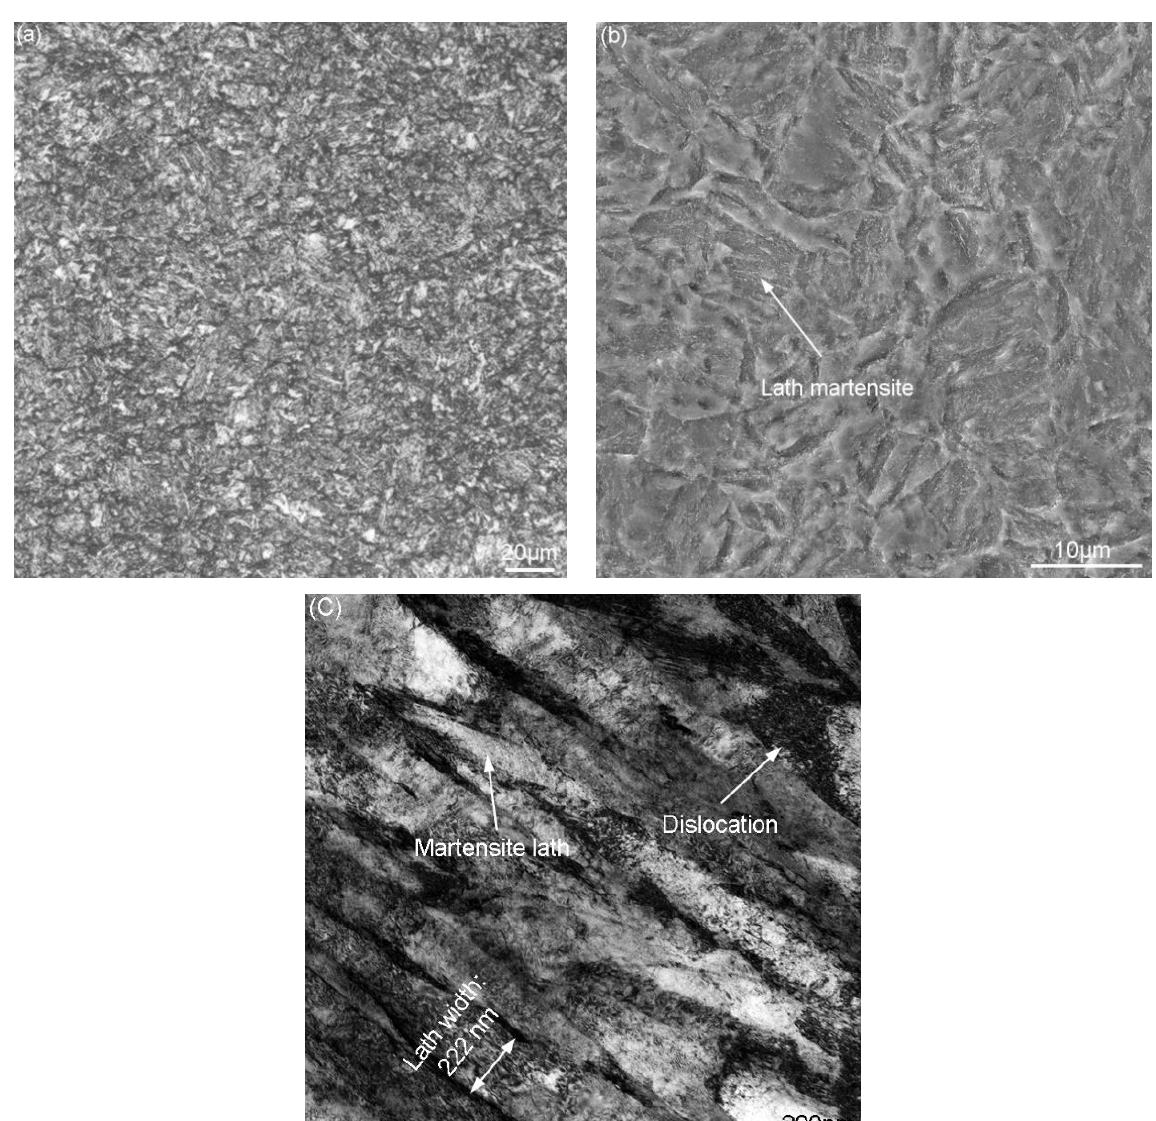
Figure 4. ( a ) OM, ( b ) FESEM and ( c ) TEM image of the matrix microstructure of the test steel.